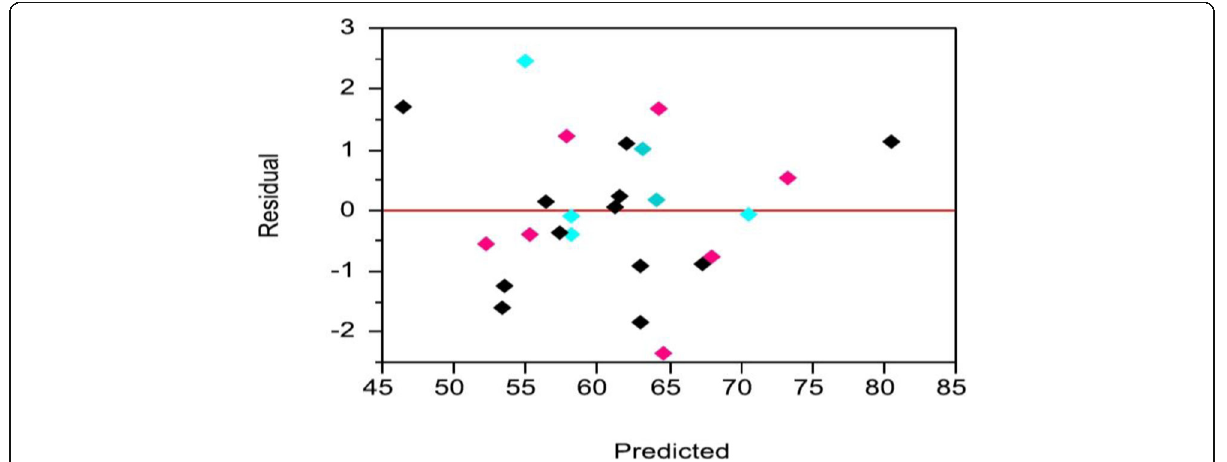
Fig. 6 The relation between predicted and residual values of α -amylase immobilization